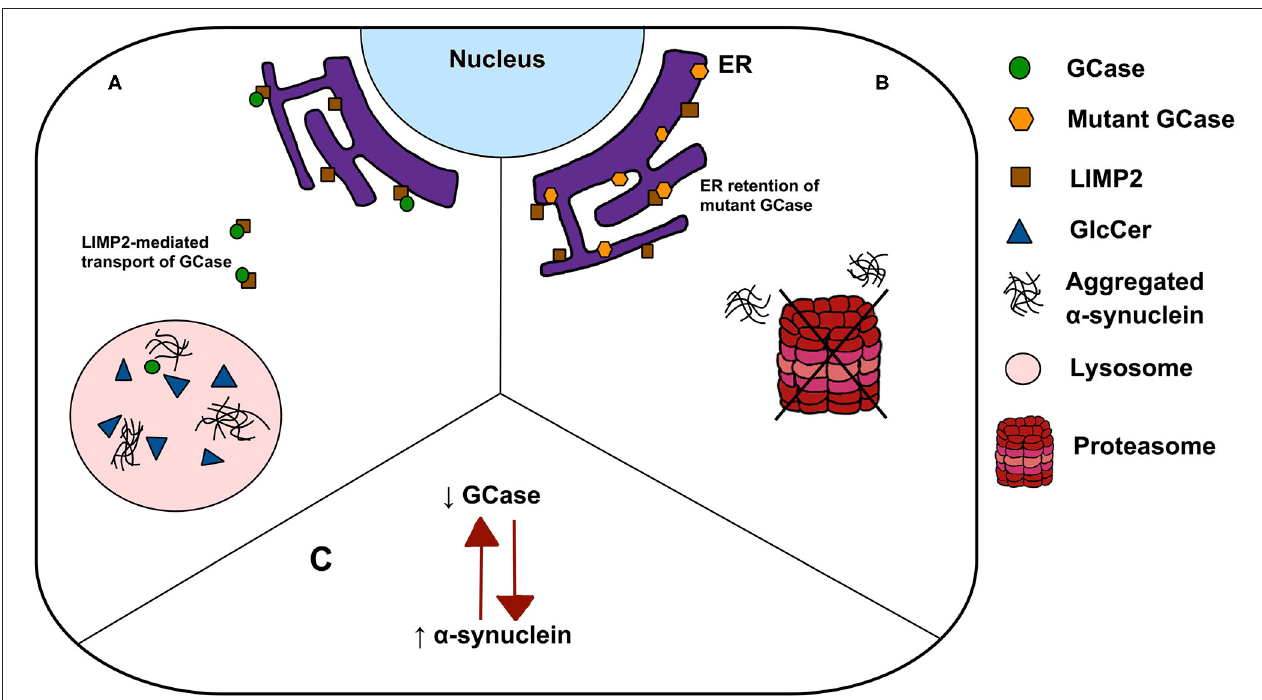
FIGURE 1 | Possible mechanisms linking GBA1 mutations to PD. (A) The loss-of-function theory postulates that In GBA1 mutation-positive patients, deficient GCase results in GlcCer accumulation, lipid dyshomeostasis and α -synuclein aggregation; (B) the gain-of-function model states that ER retention of mutant GCase leads to ER stress, enhancing α -synuclein aggregation and prevent its degradation via autophagy or the ubiquitin-proteasome pathway and (C) a bidirectional positive feedback loop, in which reduced GCase activity leads to an accumulation of α -synuclein and α -synuclein accumulation further contributes to a decrease in GCase